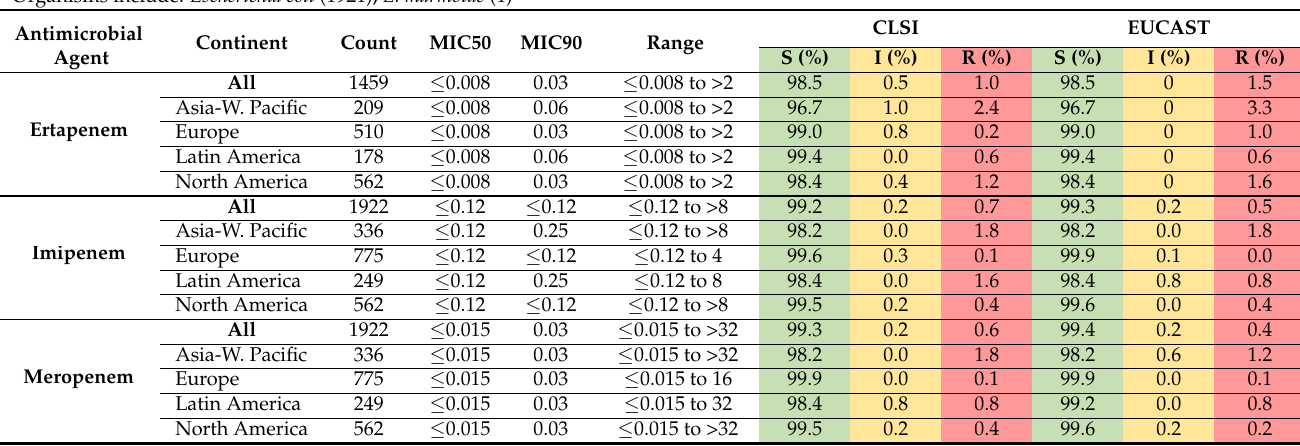
Table 5. Activity of antimicrobial agents tested against 1922 Escherichia isolates from intra- abdominal